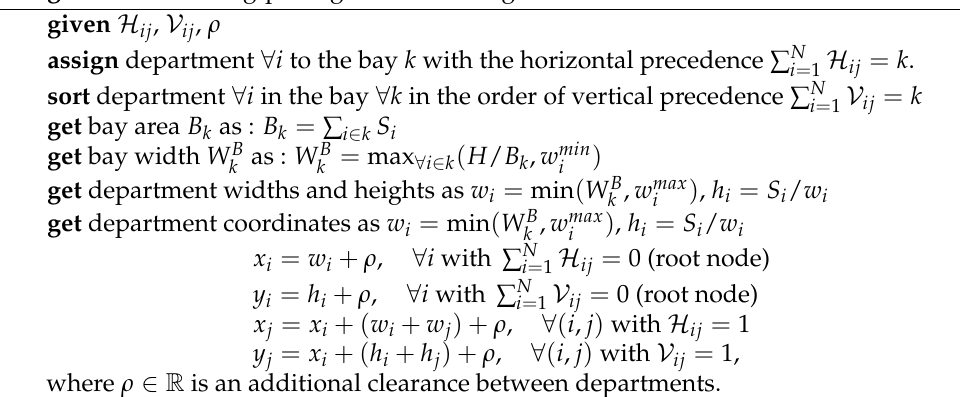
Algorithm 1: Starting-point generation using the